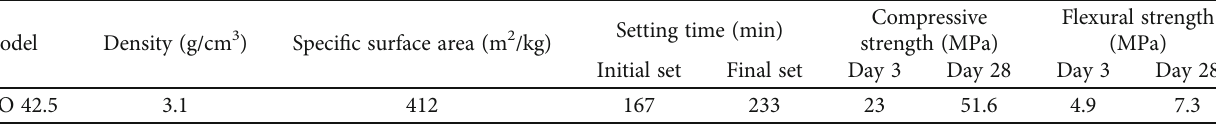
Table 1: Physical and mechanical properties of cement.